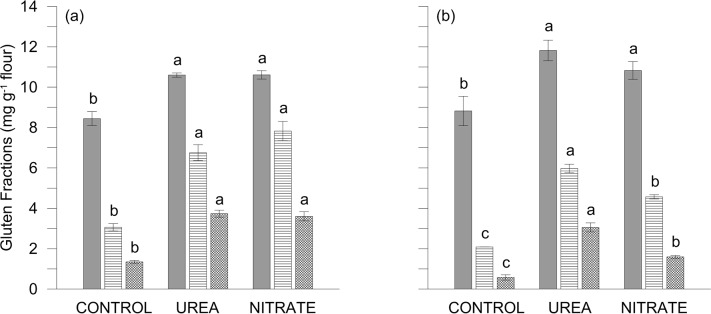
Gliadin and glutenin contents in in durum wheat mature grains under CONTROL and UREA and NITRATE fertilisation treatments.Gliadins (mg g-1 flour; grey chart) and glutenin (GS) fractions (mg g-1 flour; horizontallines: LMW-GS fraction; diagonal cross: HMW-GS fraction) in durum wheat grains fertilized with urea (UREA) and calcium nitrate (NITRATE) at the rate of 150 kg N ha-1 plus unfertilized CONTROL in 2011 (a) and 2012 (b). Data are averages ± standard errors, for n = 3 independent replicates. Different letters indicate significant differences at p<0.05 (Fisher’s LSD test).